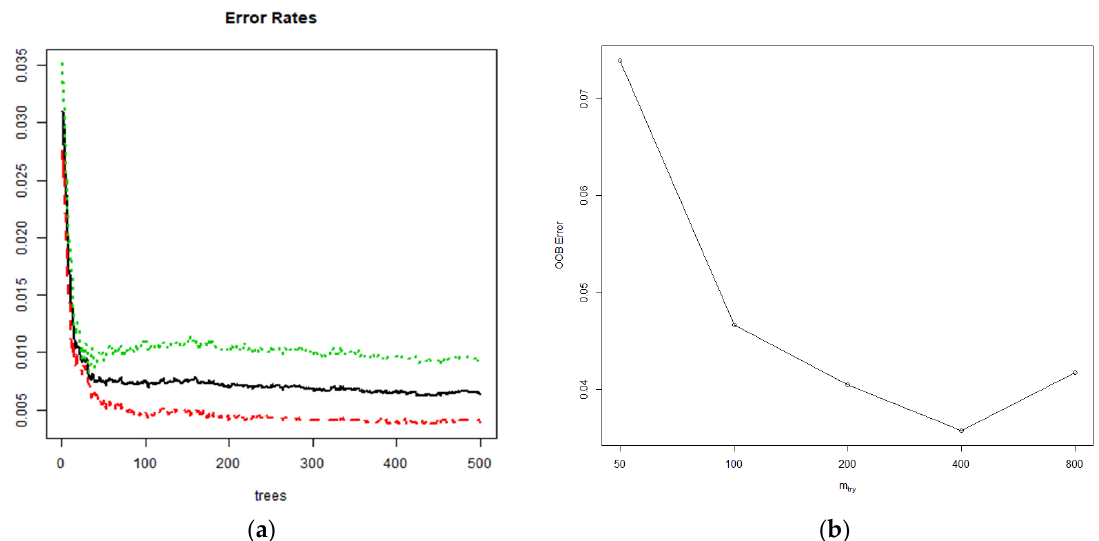
Figure 7. Variation of OOB error of Ntrees ( a ) and variation of OOB error of Mtry ( b ).